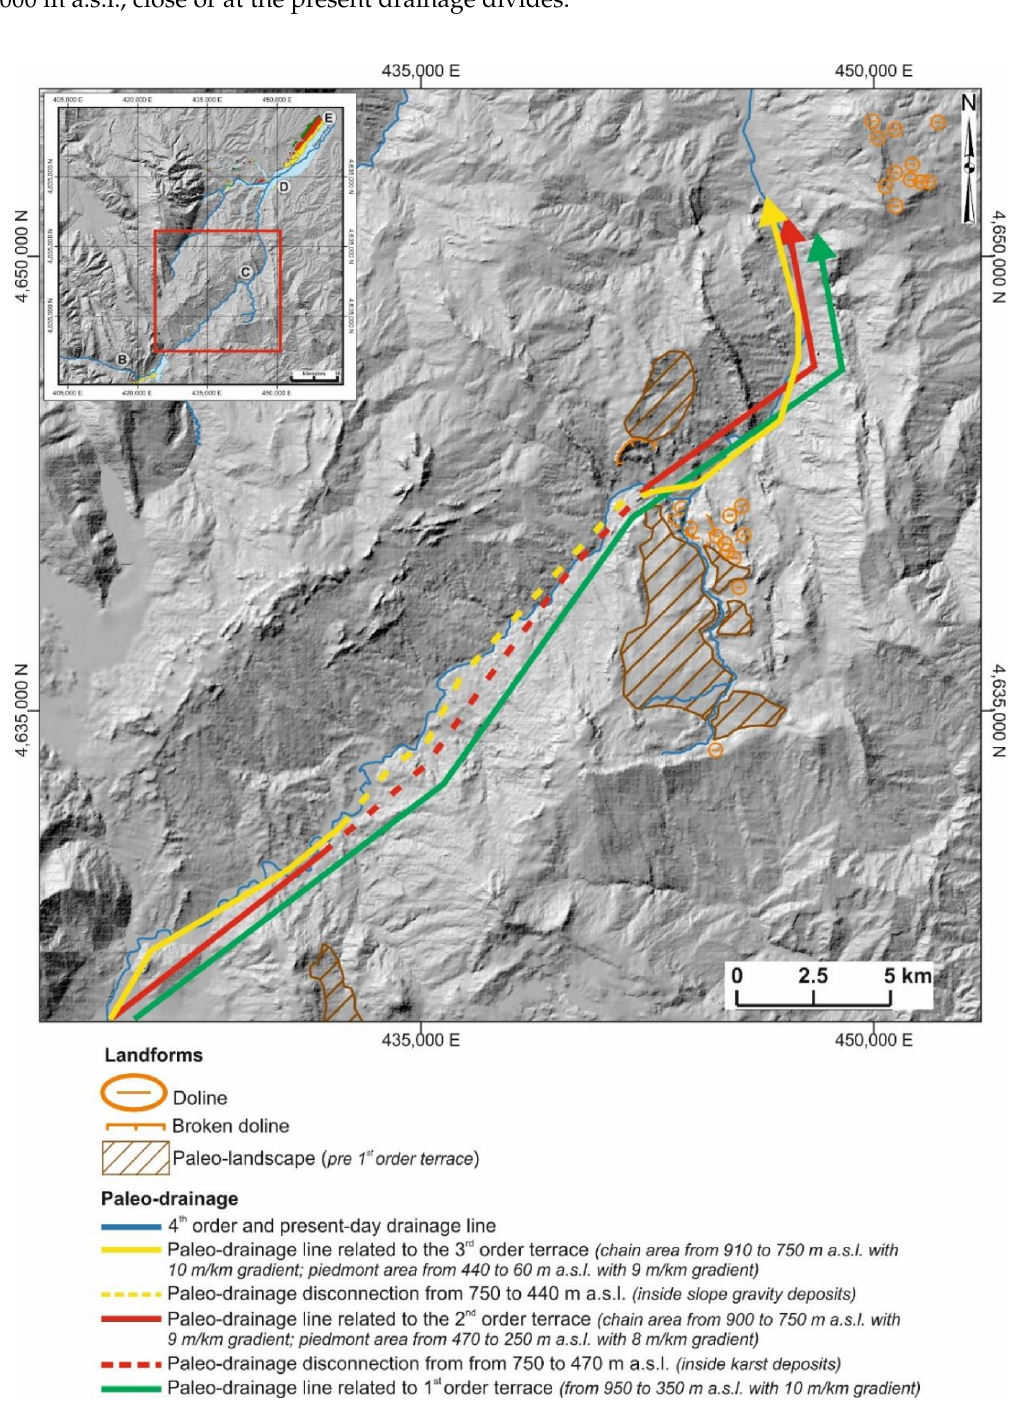
Figure 18. Possible paleo-drainage of the Sangro River at different stages. The top left shows Figure 3, to which the colors and age of the paleo-drainage